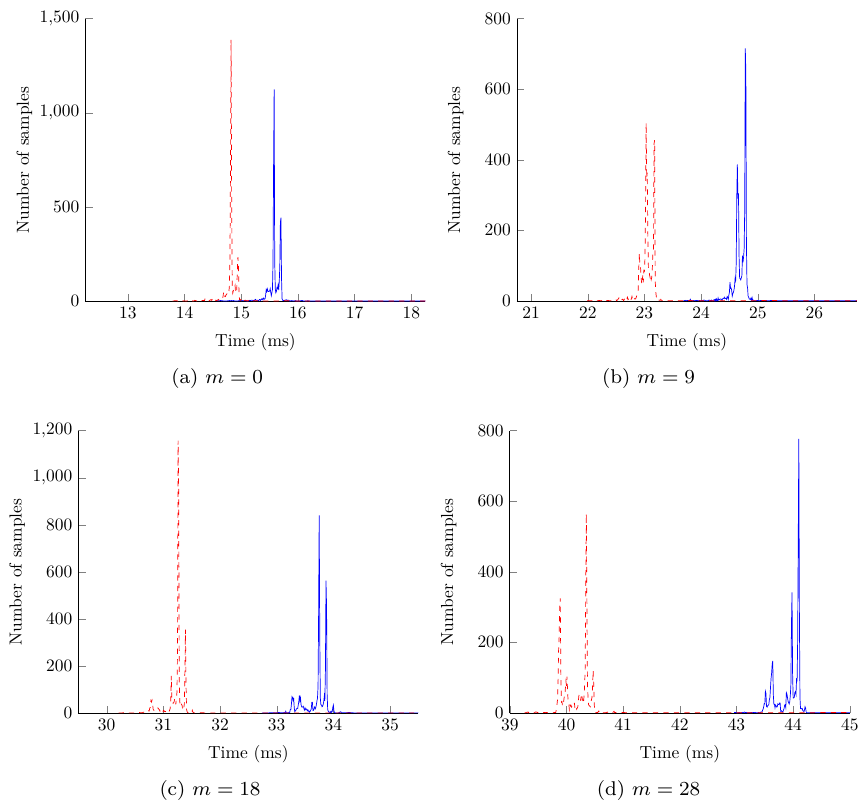
Figure 3: D R (continuous blue line) and D W (dashed red line) corresponding to Card B with different values m